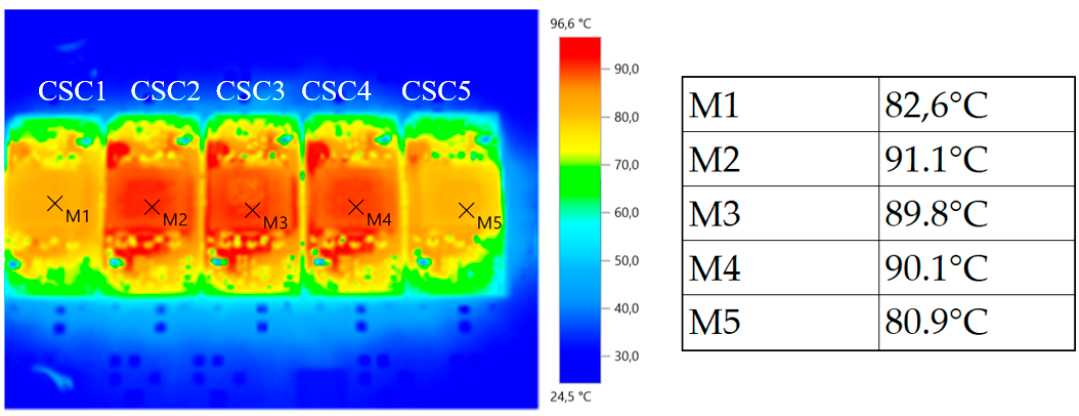
Figure 17. Thermal image of ISOS BBCBA arrangement with the following parameters Vin = 75 V; Vout = 67.5 V; Pout = 150 W.